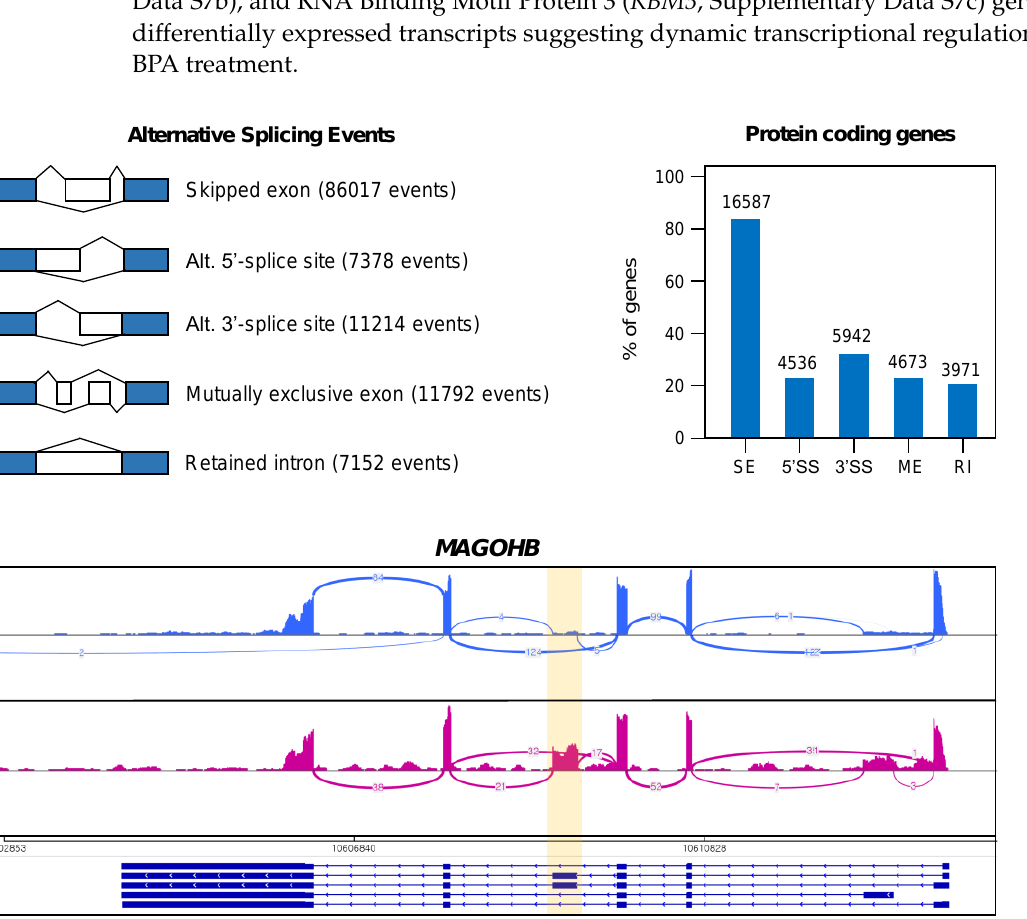
Figure 4. Transcriptome dynamics identifies the alternative splicing events in BPA-treated Y79 cells. ( a ) Alternative splicing events were analyzed by the MATS and identifies alternative splicing events. Types of alternative splicing events detected and counted their frequencies in group-wise comparisons. Protein coding genes obtained from alternative splicing events indicated as the percentage of genes. Differential splicing events in the BPA-treated group shown the clear retained intron (RI) in Mago Homolog B, Exon Junction Complex Subunit ( MAGOHB ) ( b ) and Heterogeneous Nuclear Ribonucleoprotein D ( HNRNPD ) ( c ) genes. The yellow shadow indicates the retained intron region in BPA-treated Y79 cells .